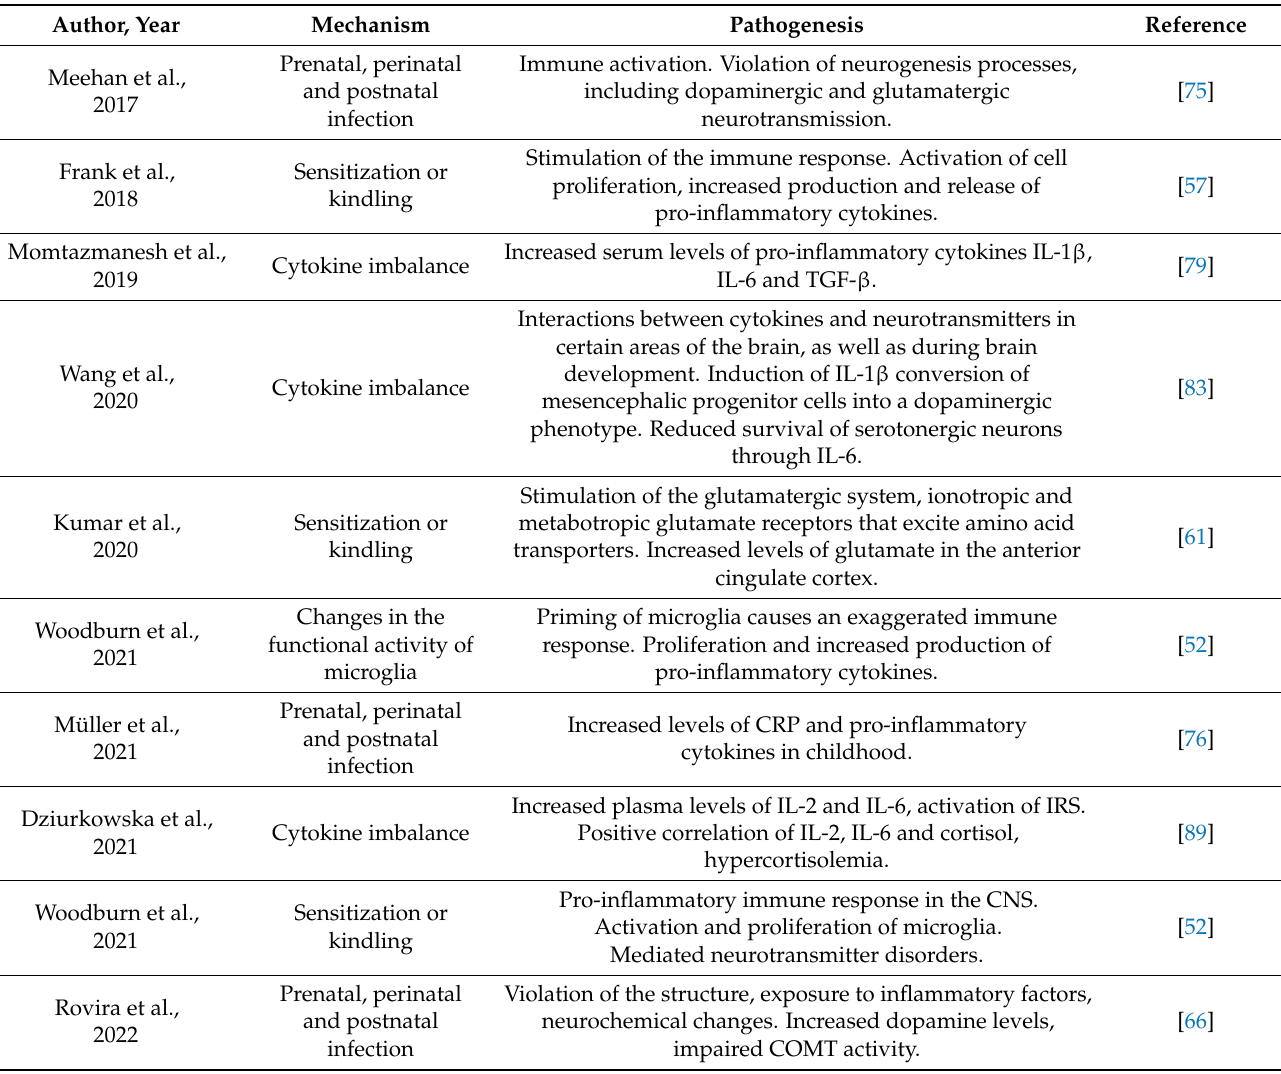
Table 2. Studies of the role of neuroinflammation in the development of treatment-resistant